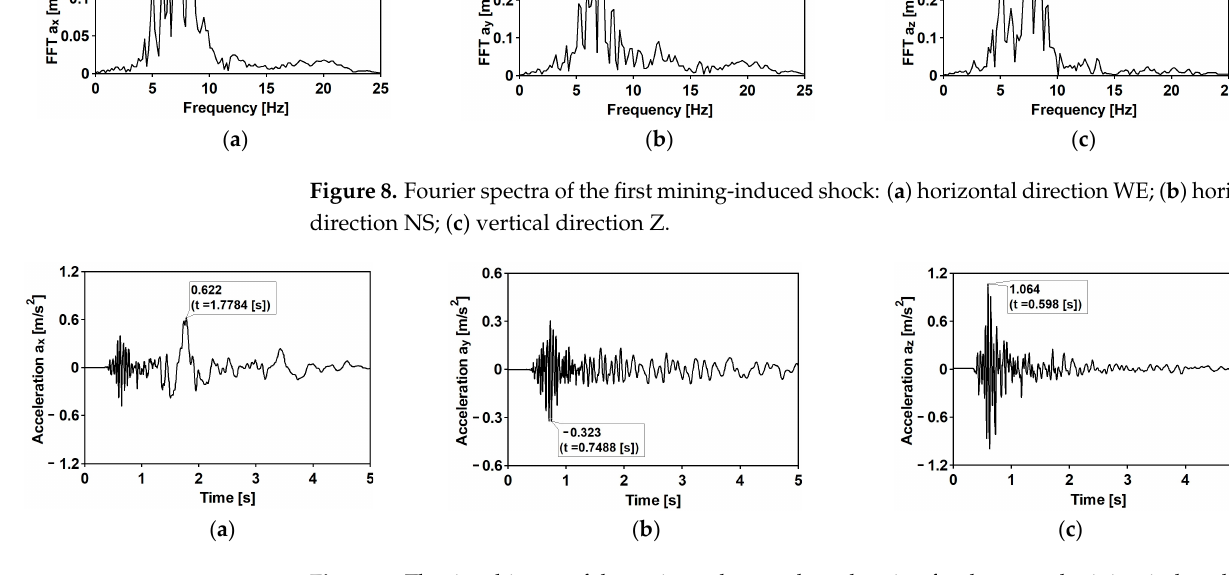
Figure 8. Fourier spectra of the first mining-induced shock: ( a ) horizontal direction WE; ( b ) hori- zontal direction NS; ( c ) vertical direction Z.